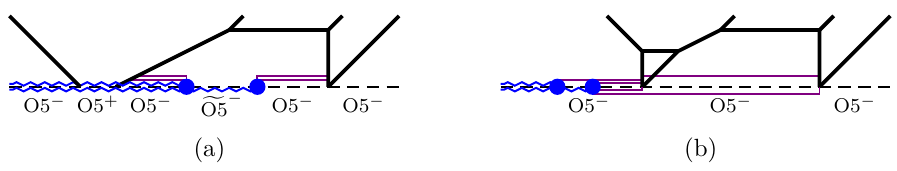
Figure 14. (a) Coupling a spinor ( − 1 , 1) 5-brane to SU(3) theory with Z 2 twist. (b) Applying the generalized flop transition and moving the half D7-branes and monodromy cuts to the right. Several half D5-branes are created due to the Hanany-Witten transition.